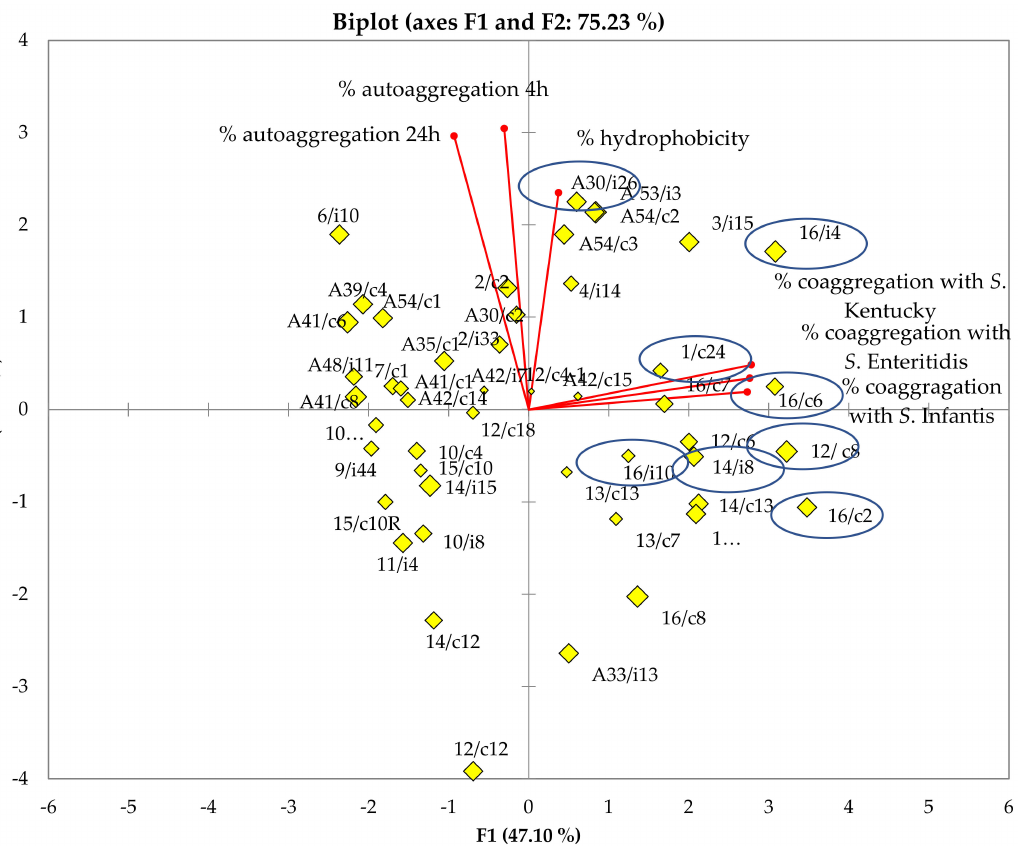
Figure 3. Graphic representation of the principal component analysis (PCA) of surface proprieties, including hydrophobicity and auto/co-aggregation, for the 48 lactobacilli isolated stains. The selected stains are